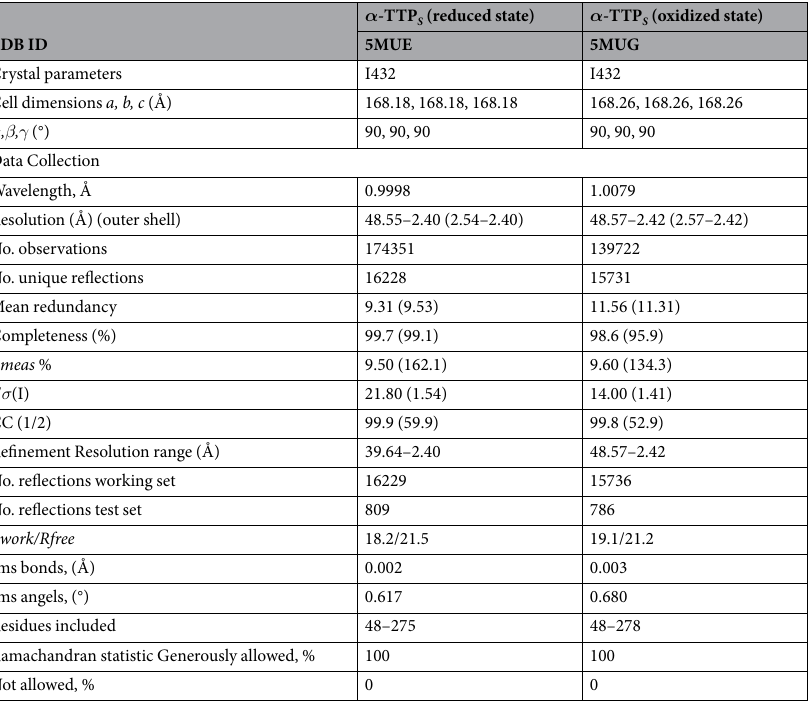
Table 1. Data collection and refinement